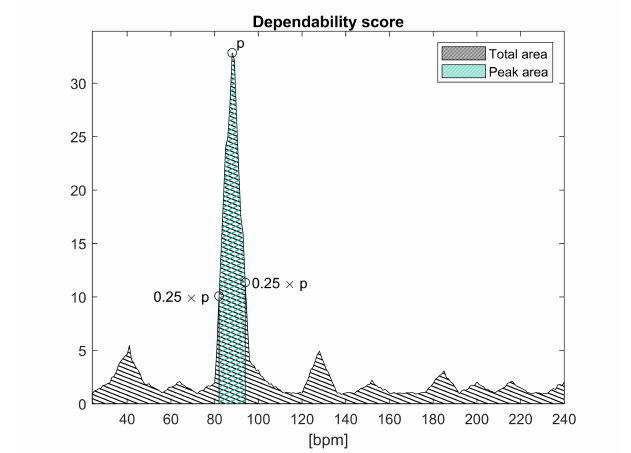
Figure 3. Dependability score definition. Both periodic head movement and pulsating light scores are defined as the ratio between area under peak (green) and total area